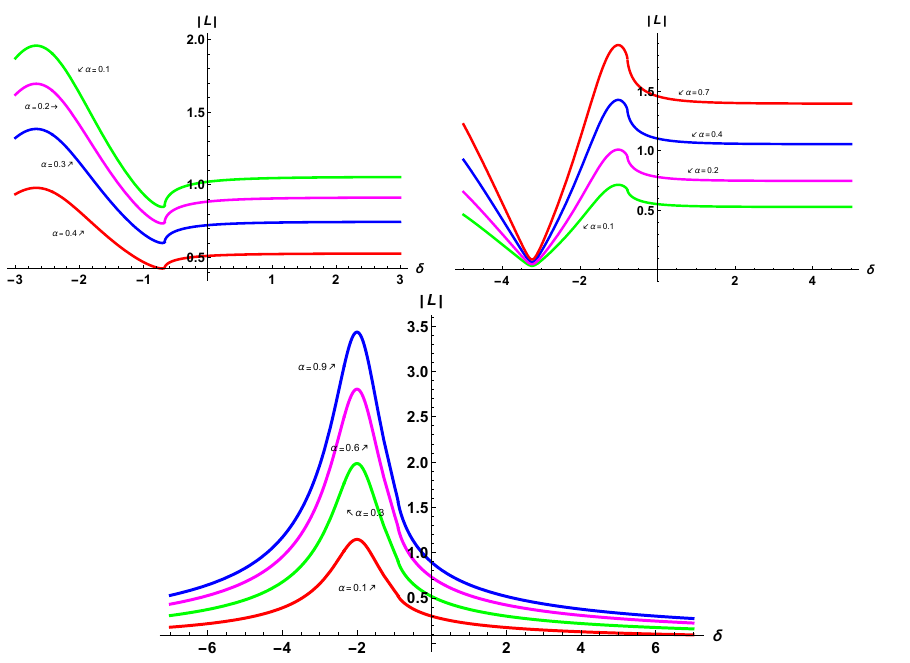
Figure 14. The 2D plots of solitary-wave solution across different values of dispersion coefficient ( α )